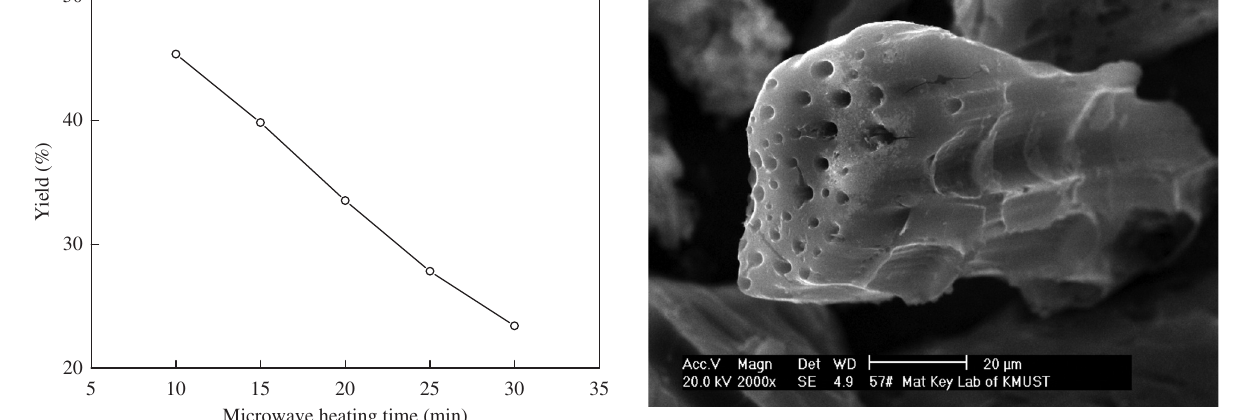
Figure 8: Effect of microwave heating time on the activation yield of activated carbon.